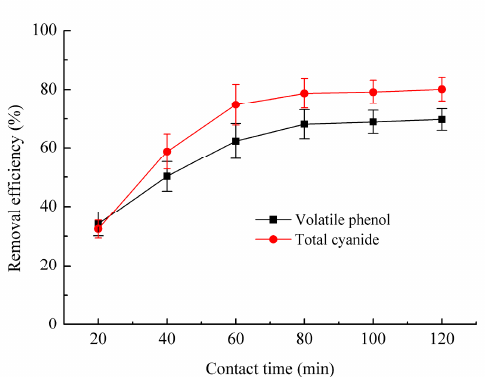
Figure 5. Effects of contact time on the removal efficiencies of volatile phenol and total cyanide. Error bars represent the range of data from duplicate experiments.